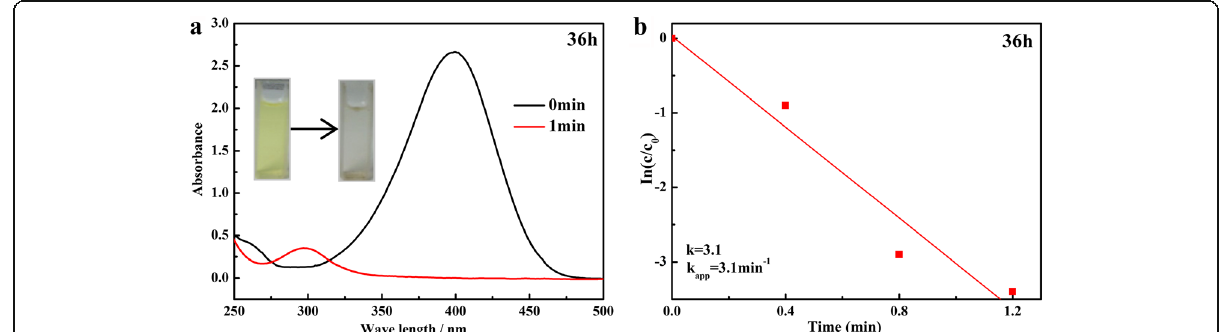
Fig. 6 a , b Time-dependent UV – Vis absorption spectra and the plot of ln( C t / C 0 ) versus reaction time for the reduction of 4-NP of the sample prepared at 150 °C for 36 h